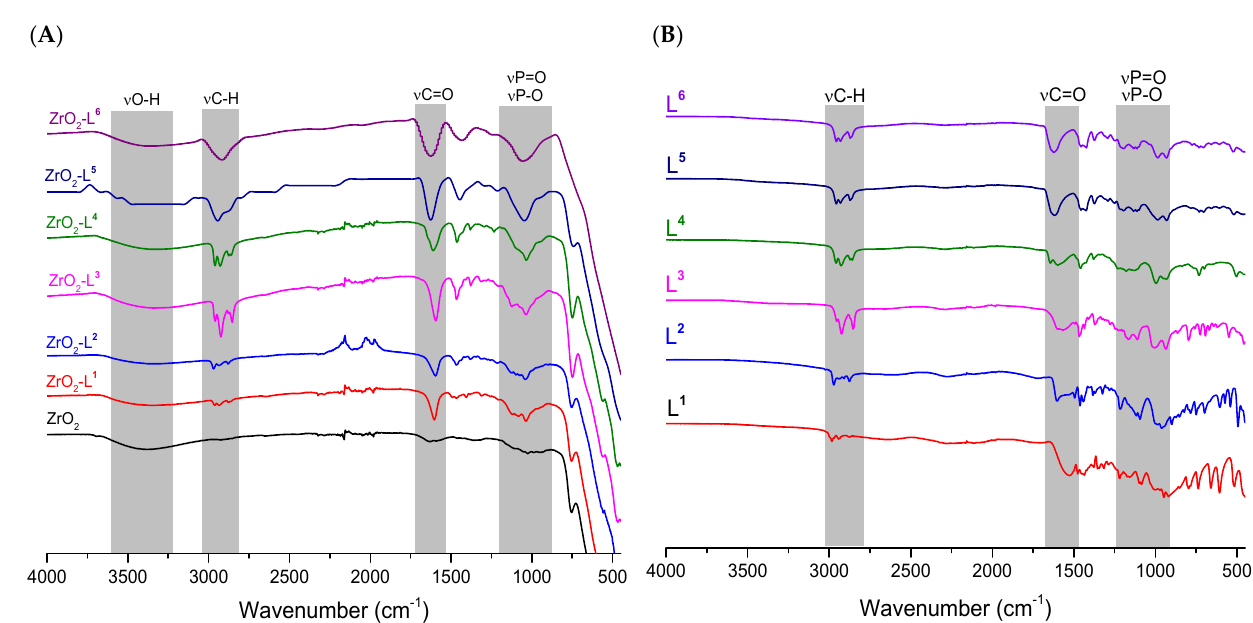
Figure 1. ATR-FTIR spectra of ( A ) ligands L n and ( B ) ZrO 2 -L n nanomaterials. Figure 1. ATR ‐ FTIR spectra of ( A ) ligands L n and ( B ) ZrO 2 ‐ L n nanomaterials. The shielding of the chemical shifts (5–7 ppm) between ZrO 2 -L n and free ligands Solid state 31 P NMR of modified nano ZrO 2 with phosphonic acids organic ligands demonstrated that the electron density is higher around the P nuclei of the supported (L n ) allowed to study the binding mode (monodentate, bidentate, or tridentate) of the ligand, which might be due to the charge of the phosphonate anion. The values of the phosphonic groups, and the different types of physisorbed and/or chemisorbed phospho ‐ nate species on the zirconia surface (Figure 2). While all liquid ‐ state 31 P NMR spectra of chemical shift suggested that for mono-carbamoyl ligands, we had mostly a bidentate the organic phosphonic ligands showed very sharp peaks, 31 P solid ‐ state NMR spectra of coordination mode. In the case of di-carbamoyl ligands, the presence of a peak with a all the hybrid zirconia exhibited broad resonance signals suggesting thus effective chem ‐ chemical shift close to that of the ligand could indicate either a physisorption of certain ical anchoring to the ZrO 2 surface. All ligands except di ‐ carbamoyls displayed a single ligands or a monodentate mode. Despite repeated washings, this peak is still present peak suggesting one major mode of grafting. for ZrO 2 :L n ( n = 5 or 6) ratios of 50. The absence of peaks with negative chemical shifts demonstrates the absence of molecular phosphonate complexes resulting from corrosion. The weight losses given by the TG analysis between 20 and 900 ◦ C and under air (Figure 3) are summarized in Table 2 and were used to estimate the contents of ligands on the surface of hybrid ZrO 2 powders and grafting densities. As shown in Figure 3, the first weight loss below 200 ◦ C was attributed to the loss of residual solvents. All surface- modified ZrO 2 exhibited a significant weight loss between 200 and 500 ◦ C, representing the removal of remaining –OH and L n ligands on the zirconia surface. It should be noted that the phosphonate parts (PO 3 ) were not totally eliminated and were still present on the surface after calcination at 900 ◦ C in the form of phosphate. Nevertheless, the results showed that the theoretical and experimental weight losses between 200 and 500 ◦ C are in agreement